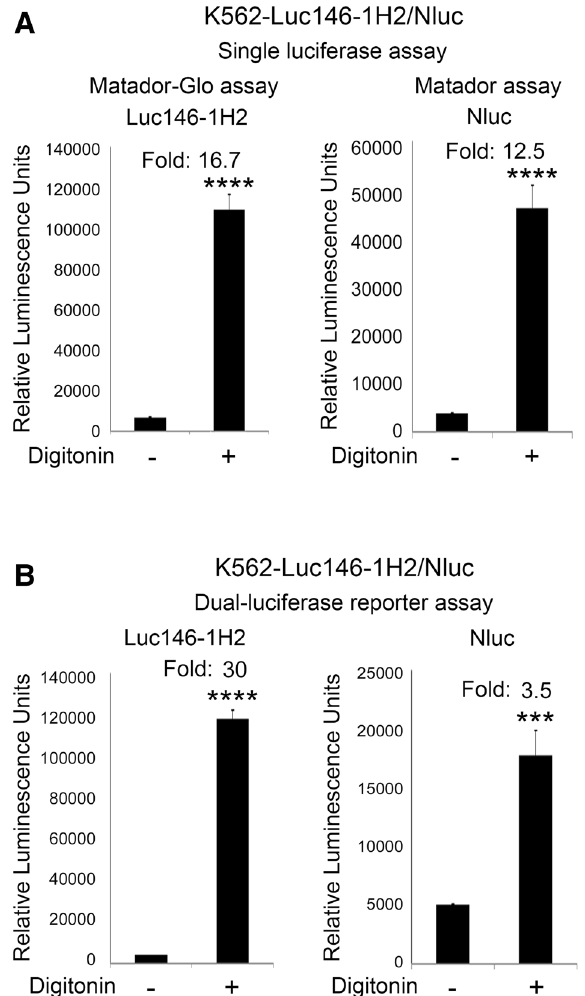
Figure 6. Matador-Glo assay can be coupled with Matador assay. ( A ) K562 cells stably expressing both Luc146-1H2 and Nluc (K562-Luc146-1H2/Nluc) were treated with digitonin (30 µg/ml) for 90 min. Post- incubation supernatants was carefully transferred to a 384-well plate to measure Luc146-1H2 activity using D-luciferin as a substrate (Matador-Glo assay) and Nluc activity using native coelenterazine as a substrate (Matador assay), respectively. ( B ) Dual-Luciferase Reporter assay kit from Promega (E1910) was used to measure samples from the same experiment as ( A ). Luc146-1H2 activity was measured first by adding Luciferase Assay Reagent II (LAR II). After quantifying the Luc146-1H2 activity, the Nluc activity was measured by adding Stop & Glo reagent to the same wells. The Stop & Glo Reagent both quenches the Luc146-1H2 signal and initiates the Nluc luminescence. The values shown are mean ± SE of a representative experiment performed in triplicate for at least two times. Statistically significant differences are shown by asterisks (***) at a level of P < 0.001 and (****) at a level of P <